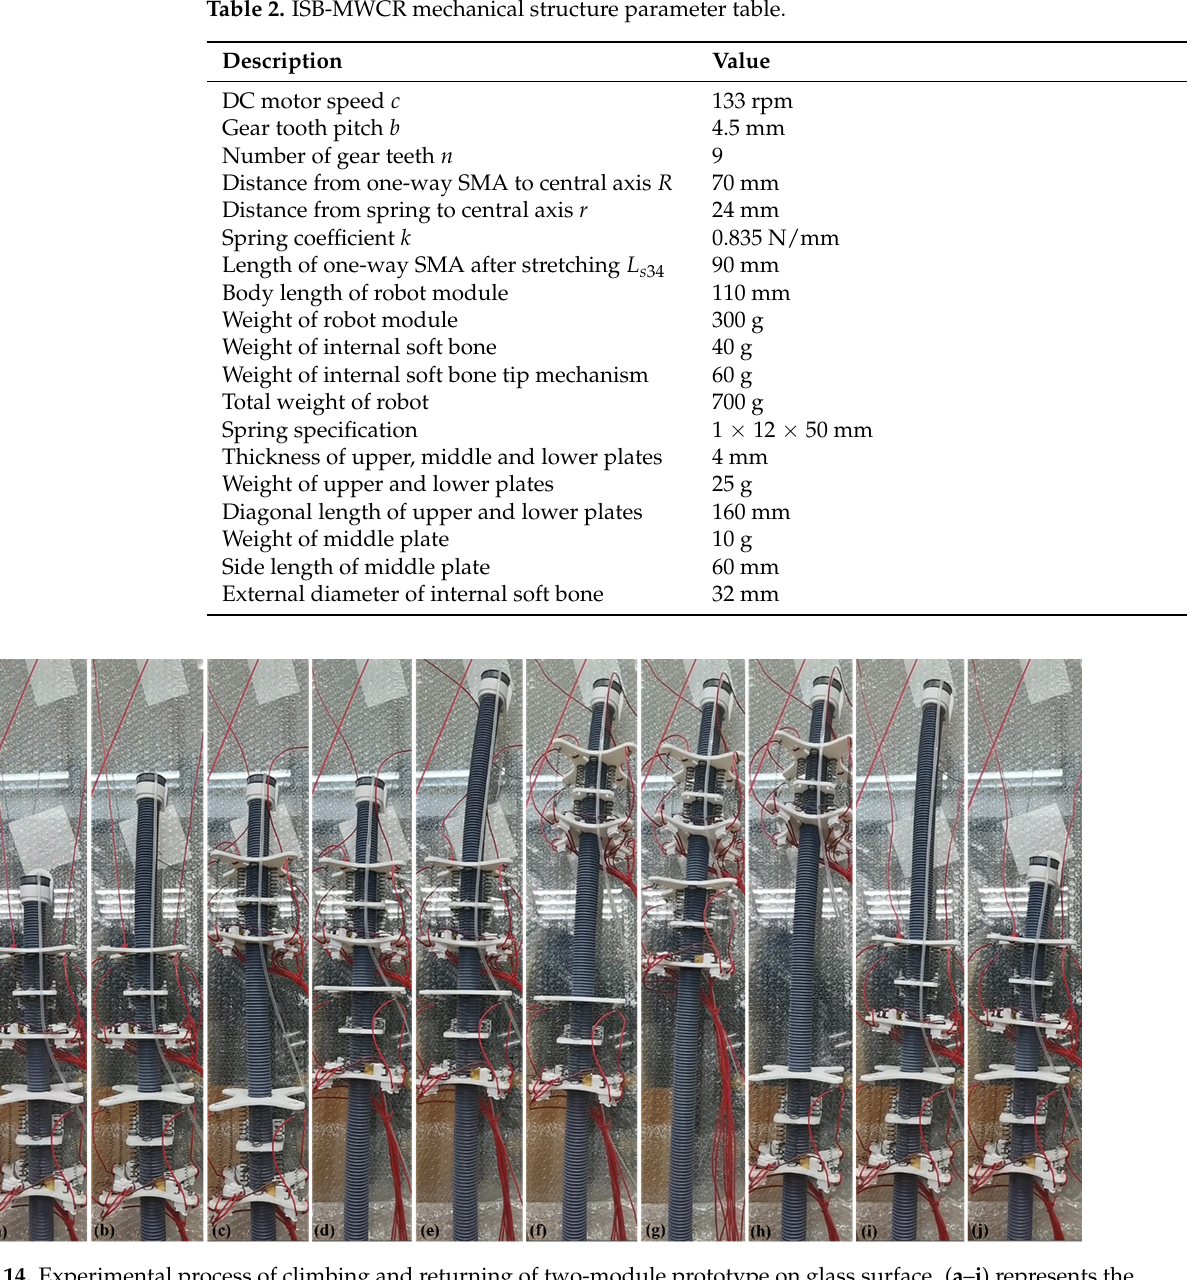
Figure 14. Experimental process of climbing and returning of two-module prototype on glass surface. ( a – j ) represents the motion of the